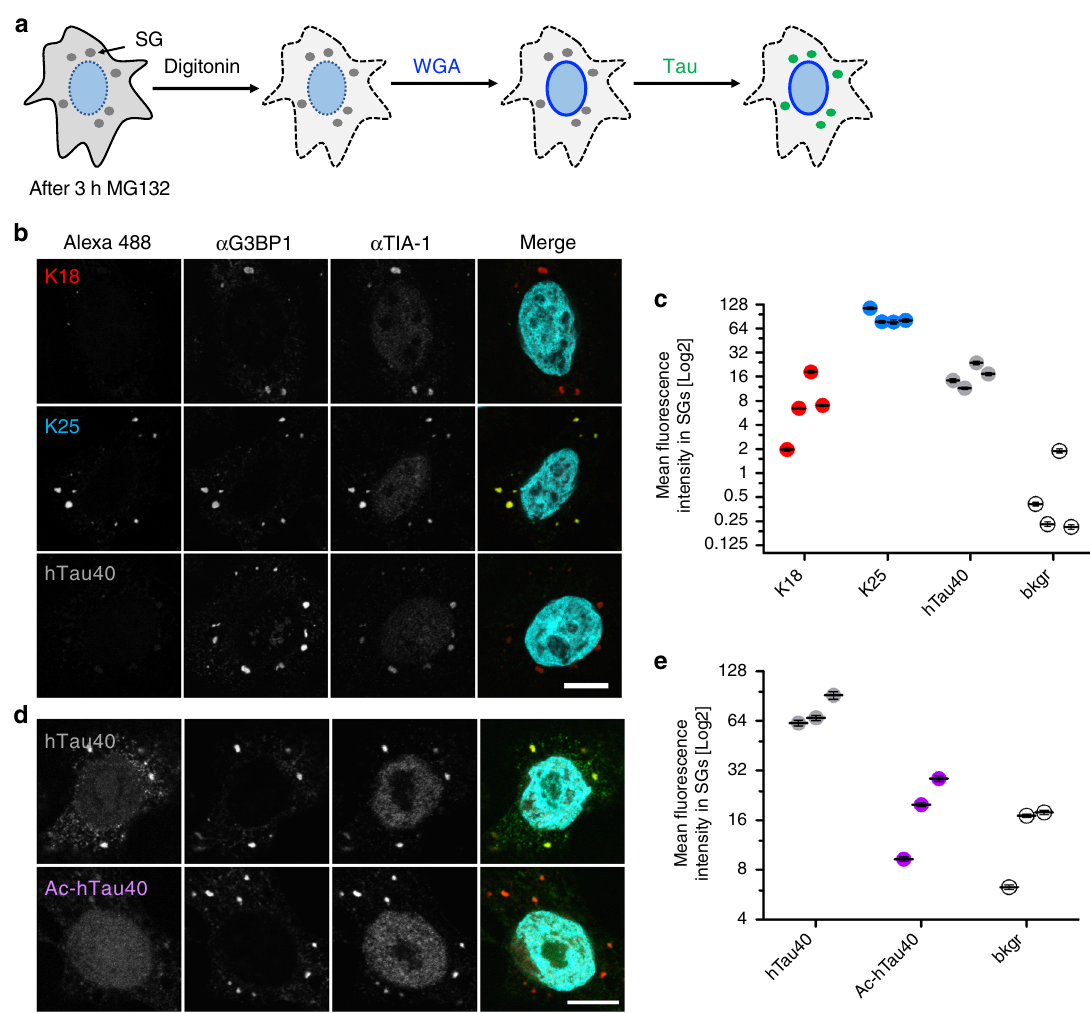
Fig. 8 In fl uence of tau domains and lysine acetylation on SG association of tau. a Schematic diagram illustrating the semi-permeabilized cell assay. After SG induction by MG132, the plasma membrane of Hela P4 cells is selectively permeabilized using digitonin, cytosolic soluble factors are washed out and subsequently nuclear pore complexes blocked by WGA. Next, Alexa 488-labeled tau proteins are incubated with semi-permeabilized cells to allow binding to SGs and after extensive washing, SGs were subjected to immunostaining for the SG makers G3BP1 and TIA-1. b SG association of K18, K25, and hTau40 (400 nM; degree of labeling ( “ DOL corrected ” ) = 3.7), scale bar, 10 μ m. In the merge, Alexa 488 fl uorescence (green) and TIA-1 staining (red) are shown. c Quanti fi cation showing the Log2-transformed mean fl uorescence intensity of K18, K25, and hTau40 vs. background (bkgr) in SGs. Four replicates with at least 8 – 10 cells and ≥ 25 SGs each are shown. Error bars correspond to ± SEM. d SG association of unmodi fi ed hTau40 (400 nM; DOL = 1.0) in comparison to acetylated hTau40 (Ac-hTau40) monitored by Alexa 488- fl uorescence. In the merge, Alexa 488 fl uorescence (green) and TIA-1 staining (red) are shown. e Quanti fi cation showing the Log2-transformed mean fl uorescence intensity of hTau40 and Ac-hTau40 vs. background in SGs. Four replicates with at least 8 – 10 cells and ≥ 37 SGs each are shown. Error bars correspond to ± SEM. Please note, that due to the wide range of fl uorescence intensities of the recombinant proteins in SGs, different laser settings had to be used in b when compared to d in order to avoid pixel saturation and to ensure ideal representation of the differential SG recruitment of the different proteins. Source data are provided as a Source Data fi